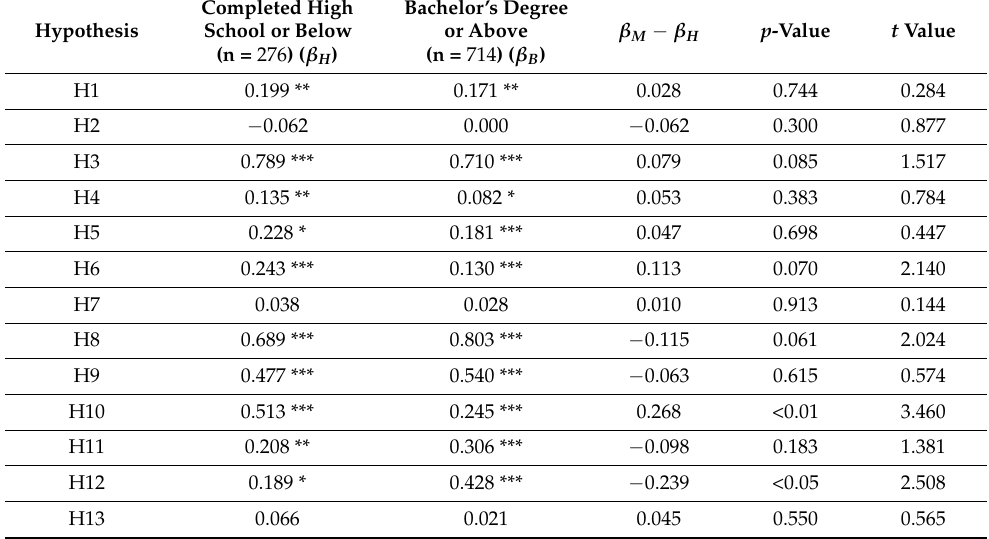
Table 9. Multi-group analysis by education level.